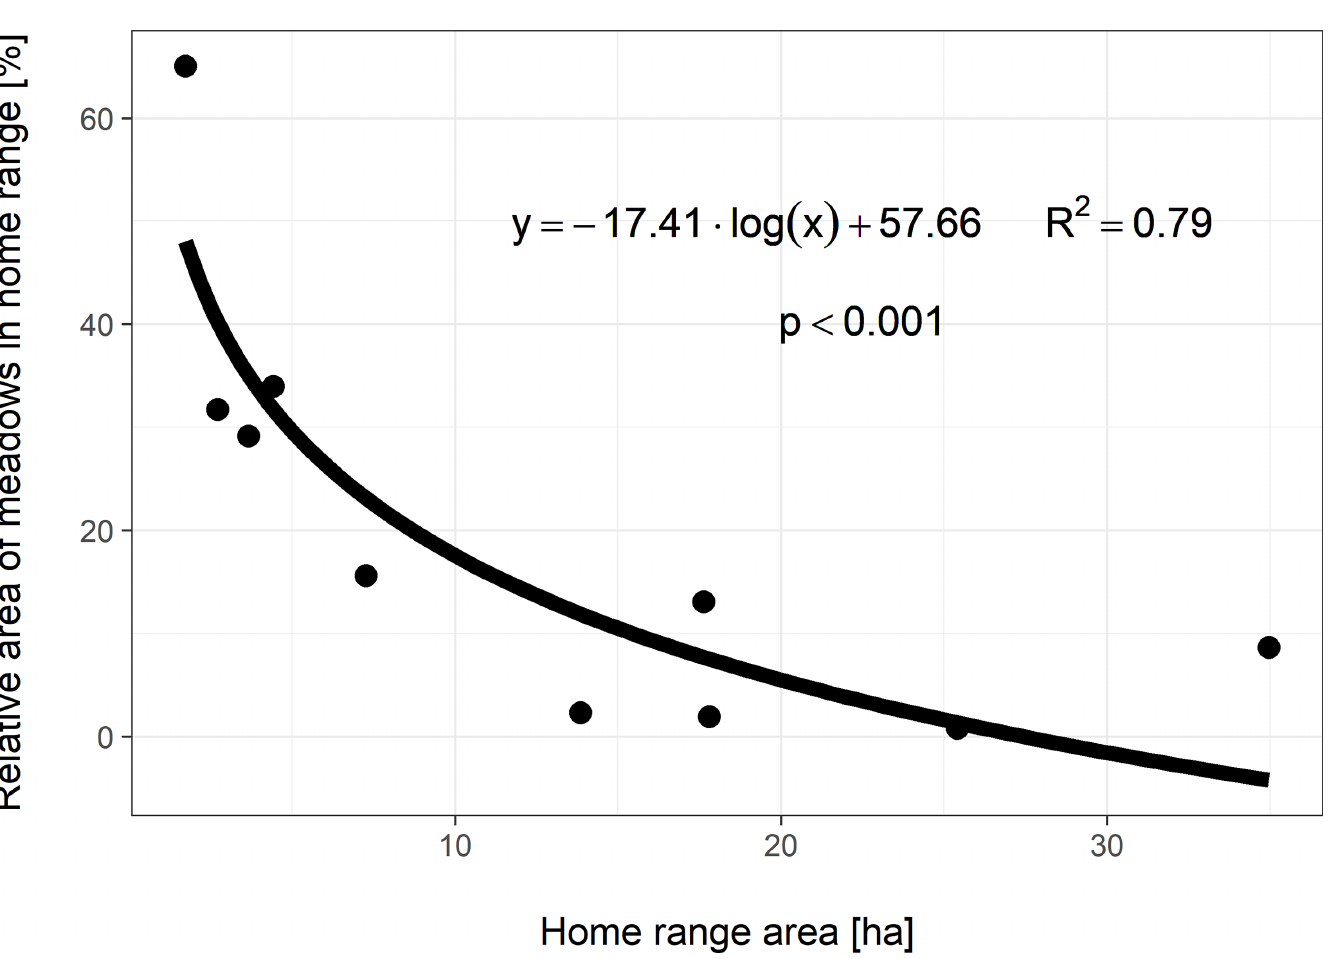
Fig 5. Meadow area percentage relative to the size of inactive home ranges. Bold line depicts regression functions described in the plot. Provided p -values for logarithmic regression assume a null hypothesis based on parameter a of the regression equation y = a (cid:3) log ( x )+ b is equal to zero. Natural logarithm was used for regression